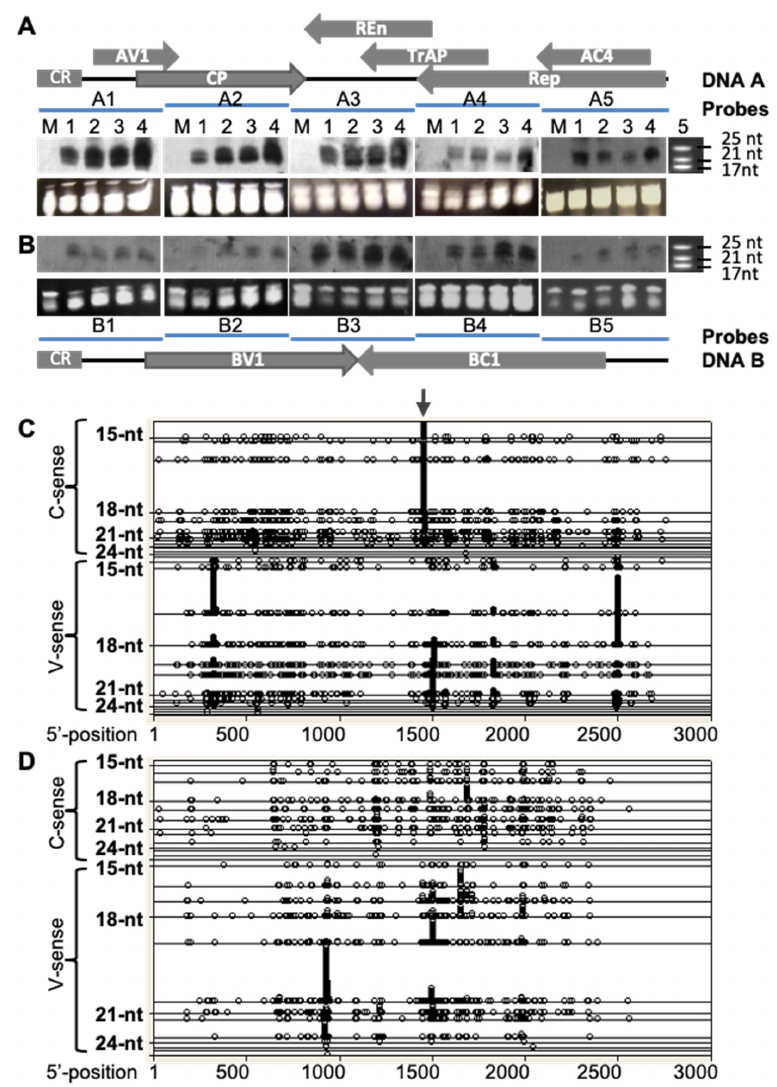
Figure 2. Profiling populations of vsiRNAs from ACMV (DNA-A and B)-infected plants. ( A , B ) Detection of ACMV vsiRNA by Northern blot. Total small RNAs were extracted from leaf tissues of mock-inoculated N. benthaniana (M), or plants infected with ACMV at 12 (lane 1), 15 (lane 2), 18 (lane 3) and 21 (lane 4) days post-inoculation. vsiRNAs of DNA-A ( A ) and DNA-B ( B ) were detected by Northern blots using probes hybridizing to separate regions of bipartite viral genome components. Genome organisations of DNA A and DNA B are indicated. Each line represents a specific probe (A1–5 and B1–5) that corresponds to approx. 560 bp fragment of the respective genome positioned below ( A ) or above ( B ). The sizes and positions of the microRNA markers (lane 5) are indicated. Loading controls are shown by GelRed-stained of total small RNAs in PAGE/8 M Urea gels below each of the small RNA blots. ( C , D ) Distribution of vsiRNAs within the ACMV genome. The profiles of vsiRNA corresponding to both virion (V)- and complementary (C)-sense strands of ACMV DNA A ( C ) and DNA B ( D ) were obtained by “454 deep-sequencing”. Each symbol represents 59 or 26 observations of siRNAs for DNA A ( C ) or DNA B ( D ), respectively. The length of vsiRNAs ranges from 15 to 29 nucleotides (nt). Distribution of each size of vsiRNAs is shown on a separate horizontal line. These blots show not only the vsiRNA distribution but also the size of vsiRNAs across ACMV genome sequences. Nucleotides of the ACMV genome are numbered as described [8]. The vsiRNA hotspot starting at nucleotide 1440 on the complementary sense strand of DNA A is indicated (arrow). Notably, vsiRNAs are likely derived from dsRNA precursors converted from viral